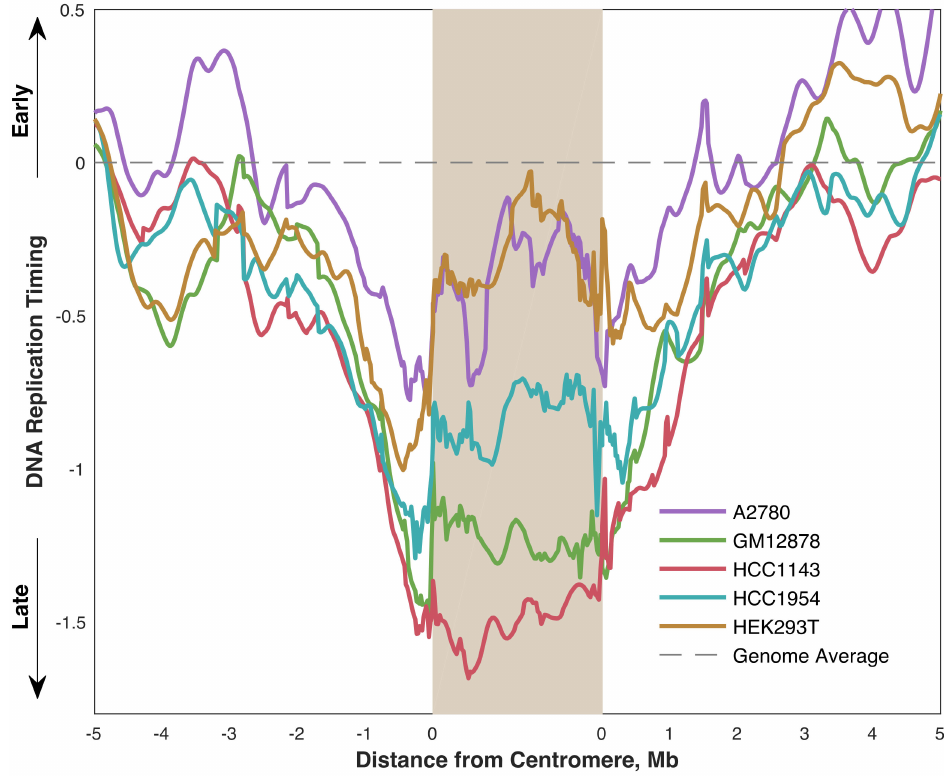
Figure 5. Centromere replication timing is variable between cell lines, occurring between mid- and mid-late S phase. Each line represents the average replication timing of mappable centromeres (see Figure 1) in the indicated cell